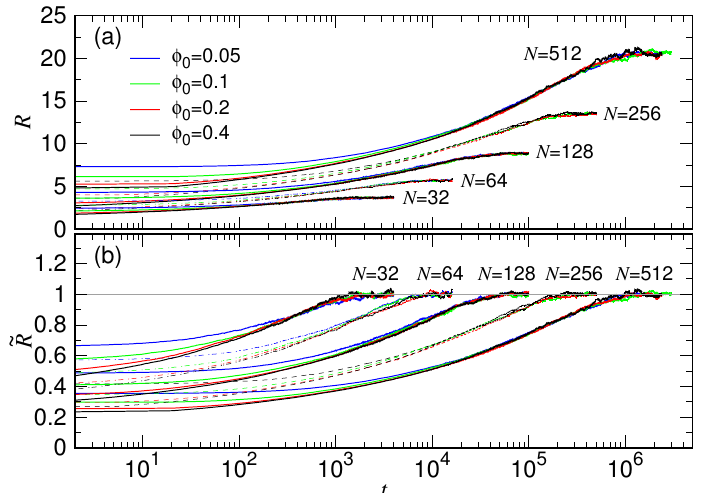
Figure 4. ( a ) R ( t ) vs. t plotted by using logarithmic scale for the time axis. ( b ) Normalized chain size ˜ R ≡ R / R F vs. t in the semi-log plot. The chain length N is indicated near the group curves. The legend for φ 0 can be read in Panel ( a ) of the figure.